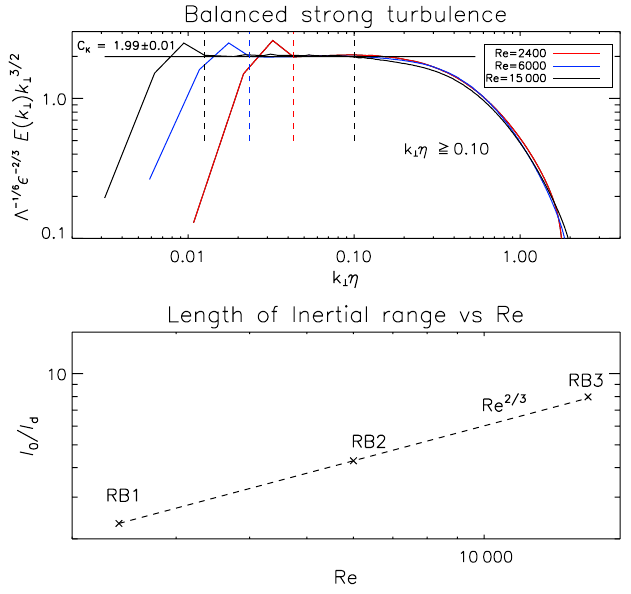
FIG. 8. Upper panel: Total field-perpendicular energy spec- trum E ð k ? Þ in balanced RMHD turbulence for different Reynolds numbers (cases RB1a, RB2a, and RB3a in Table I). The wave number is normalized by the dissipation scale (8) and the energy is compensated by (cid:1) (cid:1) 1 = 6 (cid:9) (cid:1) 2 = 3 k 3 = 2 ? . The rescaled curves collapse onto each other (up to the forcing scale) reveal- ing the universal functional form of the energy spectrum. Lower panel: The scaling of the length of the inertial interval with the Reynolds number. Good agreement with the phenomenological model (6) and (8) is